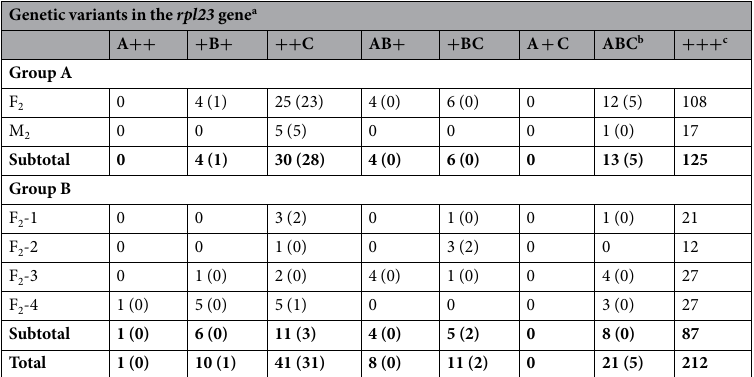
Table 1. Number of seedlings carrying different rpl23 gene variants in the two groups of cpm families. a The number of homoplastomic seedlings is shown in brackets. b A, B and C represent the polymorphic positions in the cpm rpl23 gene (blocks A, B and C). c + represents the wild type